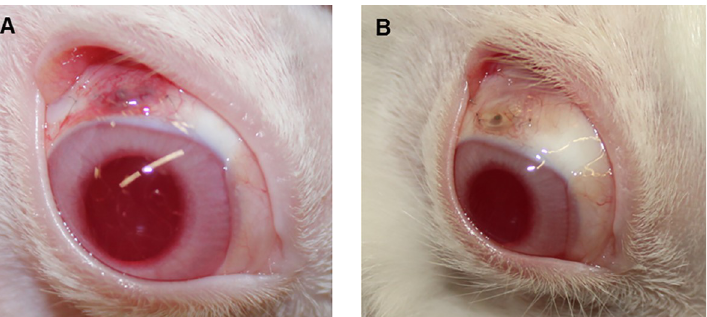
Fig 8. Clinical inflammatory reaction of one rabbit at postoperative days 3 (A) and 15 (B). Pictures A and B show the operated eye of the same rabbit at days 3 and 15, respectively, after implantation. (A) At day 3, a moderate vascularity of the implant area, slight accumulation of exudate at the cornea and mild iris hyperaemia can be seen, resulting in mild inflammation. (B) At day 15, no inflammatory signs are visible, iris and cornea are non-irritated and the vascularity of the implant area is normal. The anterior quarter of implant is uncovered due to the retracted conjunctival flap. On both occasions (pictures A and B), there is no exudate in the anterior eye chamber.